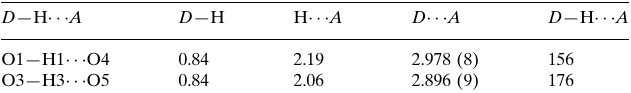
Hydrogen-bond geometry (A˚ , (cid:2)